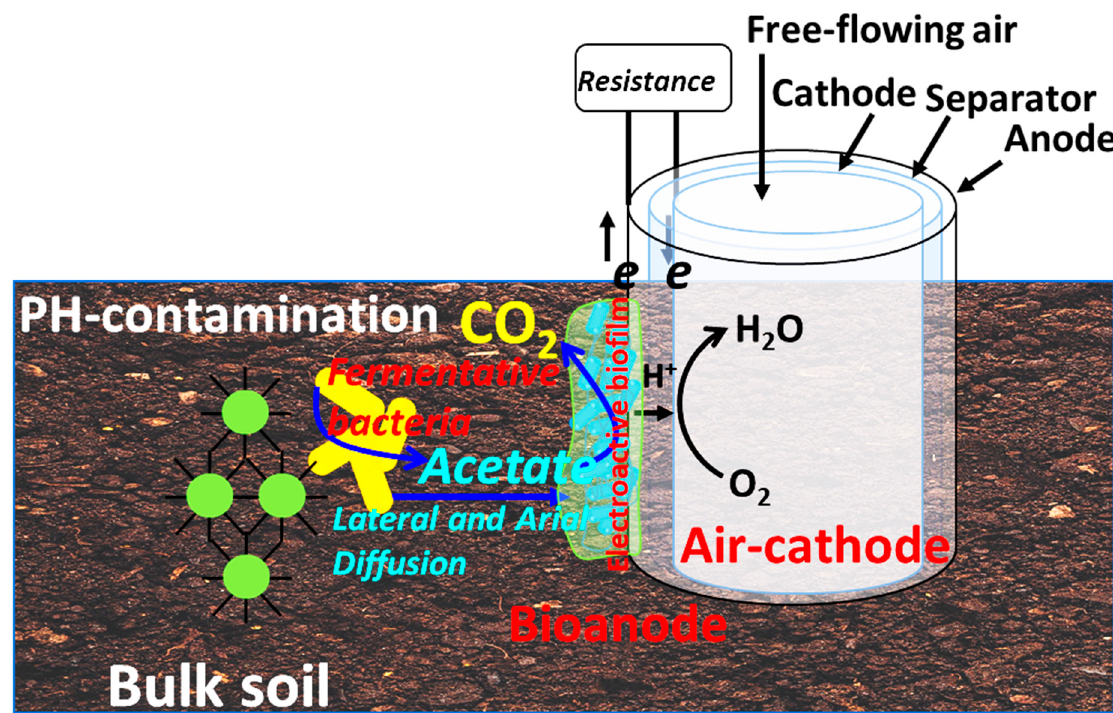
Figure 1. Schematic diagram of BES applied for PH bioremediation in soil samples.